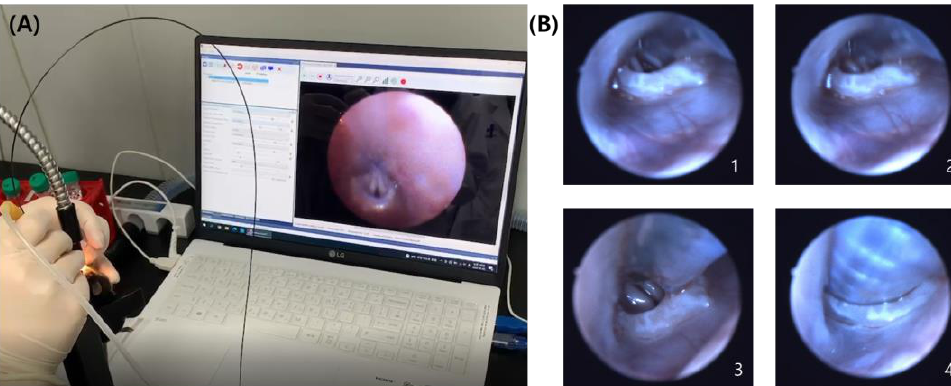
Figure 3. Intubation result image based on the manufactured system. ( A ) An experiment using an intubation system. ( B ) Intubation results in the images in rodent models. (B-1: opened vocal cord, B-2: closed vocal cord, B-3: little opened vocal cord, B-4: the inserted intubation tube when the vocal cord was opened).